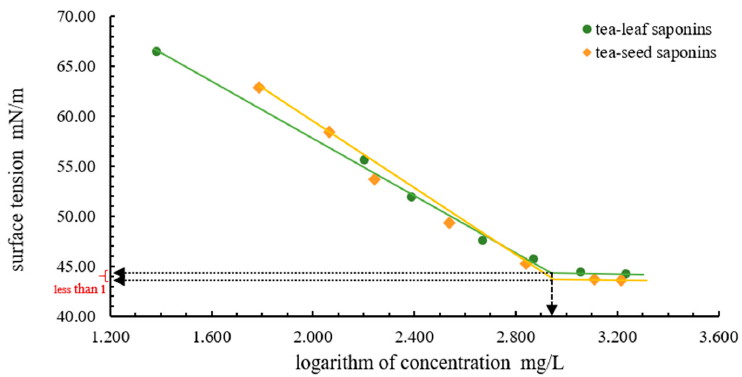
Figure 5. Surface tension versus concentration ( γ – C ) curves of tea-leaf saponins and tea-seed saponins.